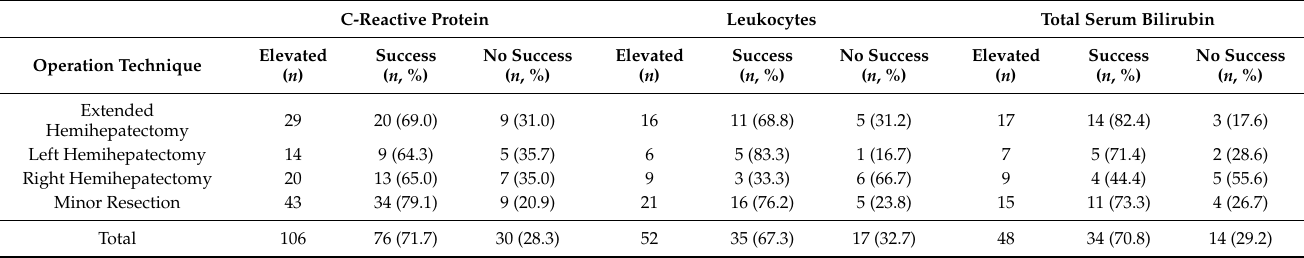
Table 5. Distribution of the success rate in terms of decreasing laboratory parameters among the different applied surgical